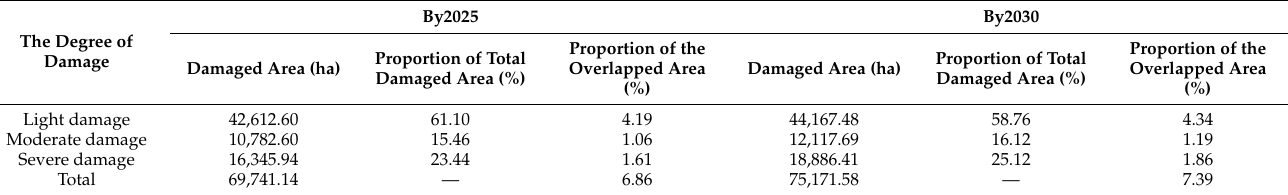
Table 4. Damaged farmland by 2025 and 2030 in